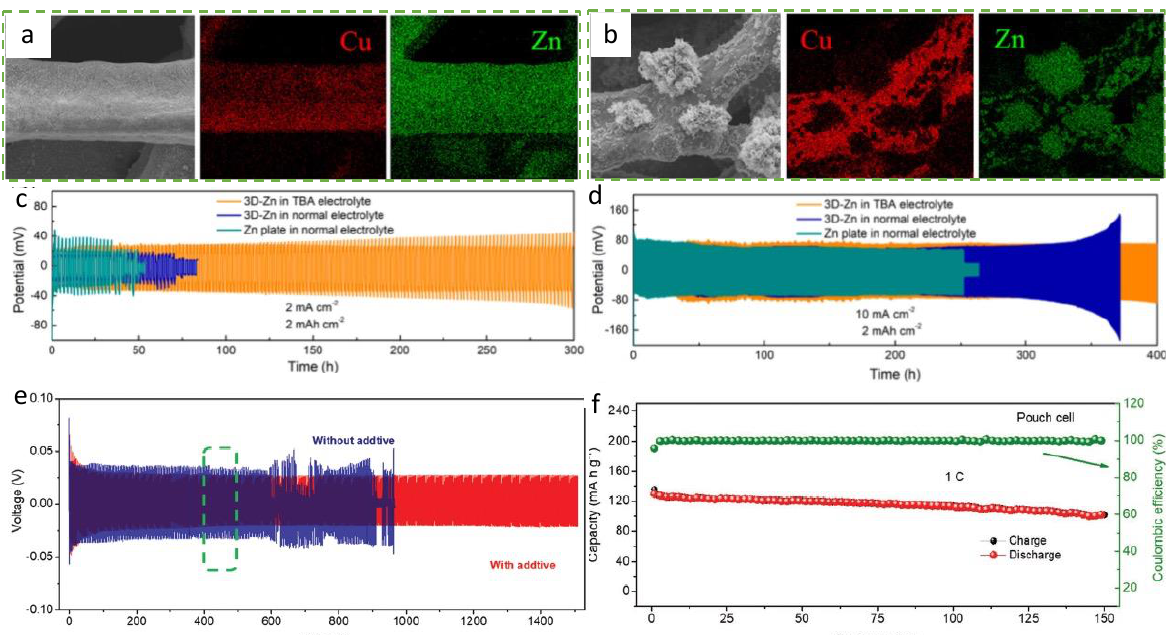
Figure 16. SEM images and EDX mapping of Zn anodes synthesized ( a ) in 2 M ZnSO 4 electrolyte with 0.05 mM TBA 2 SO 4 and ( b ) in 2 M ZnSO 4 electrolyte. Cycling performance of Zn|Zn and 3D-Zn ǁ 3D-Zn symmetric cells in different electrolytes at current densities of ( c ) 2 mA cm − 2 and ( d ) 10 mA cm − 2 . (Reproduced with permission. [181] Copyright 2020, American Chemical Society). ( e ) Polarization curves of Zn – Zn symmetric cells with/without SBDS additive at a constant current density of 0.5 mA cm − 2 and ( f ) cycling stability and Coulombic efficiency of a pouch cell at 1 C. (Reproduced with permission. [182] Copyright 2019, John Wiley & Son).